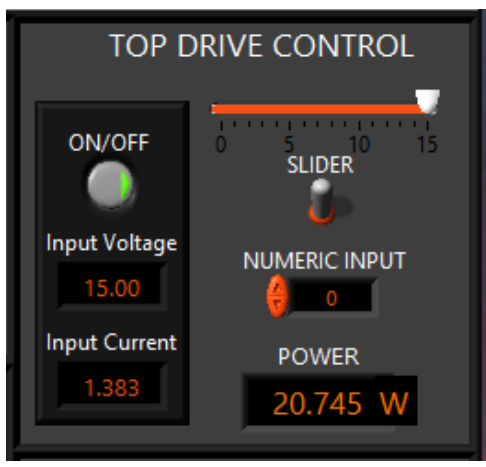
Figure 17. Top drive control panel.